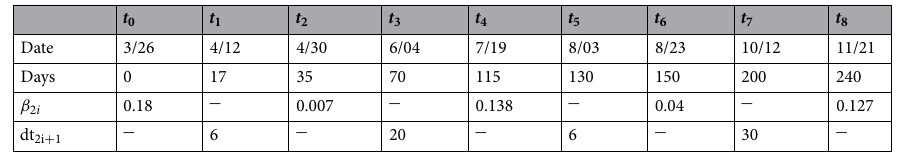
Table 1. Parameters for the fitting in Fig. 1. The quarantine rate is increased from q ( 0 ) = 0.02 to q ( 200 ) = 0.029 as explained in the text and γ = 0.04 is